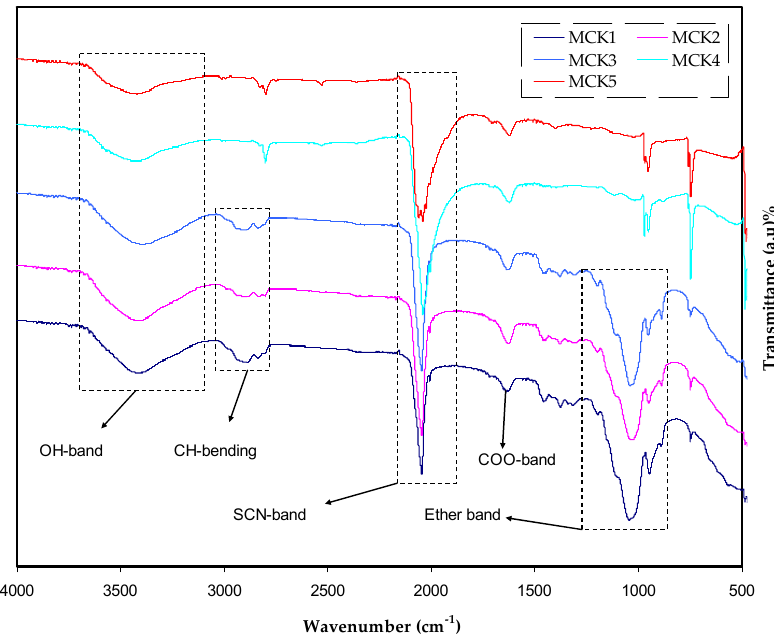
Figure 4. Full range of FTIR spectra for MC:KSCN